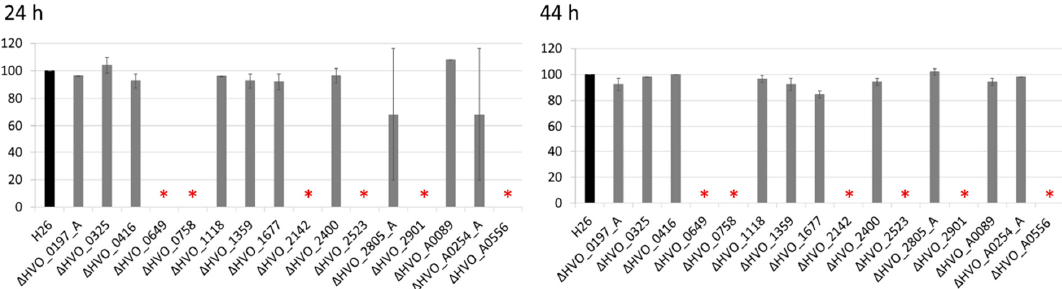
Figure 5. Comparison of the swarming velocity of the parent strain H26 (black) and its 16 deletion mutants after 24 h and 44 h incubation. Average values of three biological replicates and their standard deviations are shown. At both time points, the swarming diameters of the mutants were normalized to that of the parent strain H26 (= 100%). The wild-type had a swarming diameter of 5 mm after 24 h and 23 mm after 48 h. The cultures were injected into the semi-solid agar using a tip with 1 mm diameter. Colonies with no observable swarming with a colony diameter of less than 2 mm after 44 h were regarded to have a null phenotype. The mutants with a null phenotype are indicated by red asterisks.